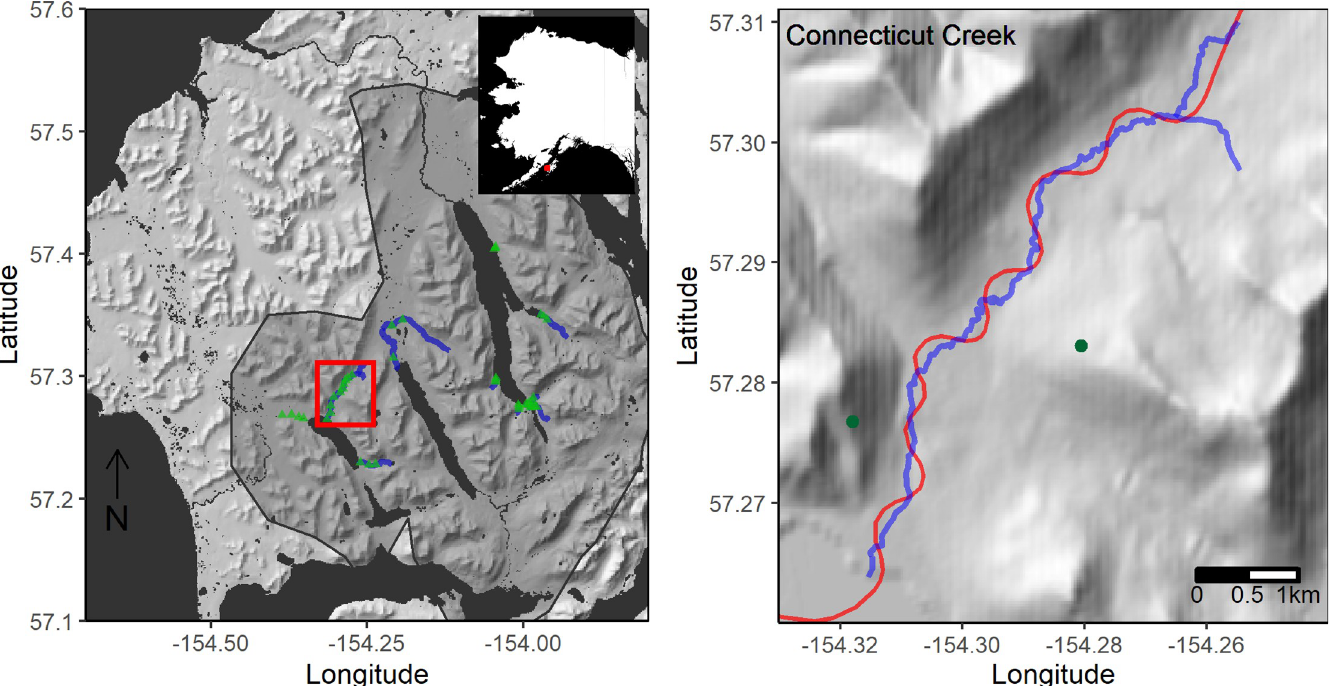
Fig 1. Study area map. Map of Kodiak, Alaska study area (left) with streams/rivers where aerial surveys occurred in blue. Green triangles show the locations of time lapse cameras, and the grey polygon shows a 90% utilization distribution of female brown bear GPS locations with a smoothing factor (h) of 0.04. The right panel shows Connecticut Creek with the GPS track of a typical aerial survey flight in red and the locations of the hill camps where spotting-scope surveys occurred as green points. Basemaps were created using publicly available data from the US Geologic Survey.